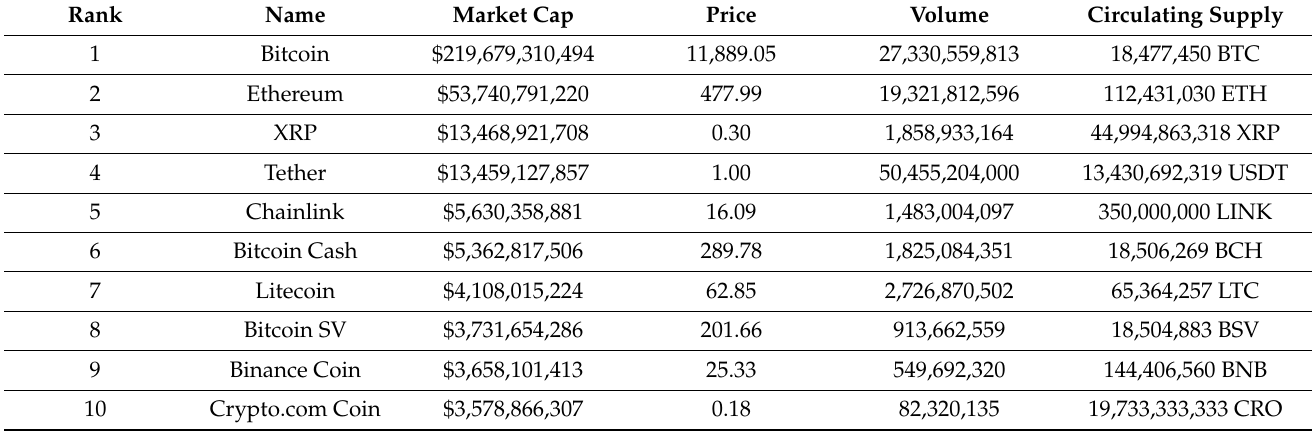
Table 1. The top 10 on market capitals of cryptocurrencies in